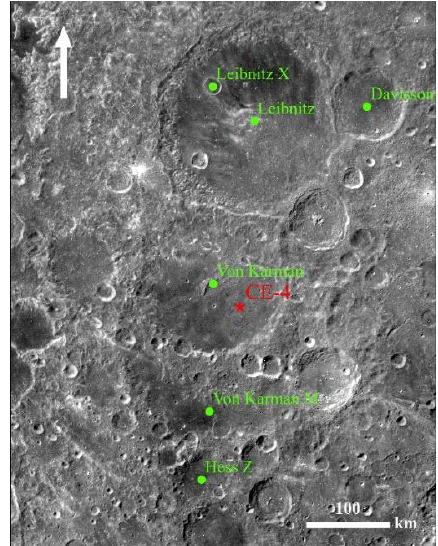
Figure 1. Geographical context of the CE4 landing area. The central location is (177.07° E, 43.19° S). The basemap is Chang’e -2 (CE-2) Digital Orthophoto Map (DOM) mosaic. The crater names are from the International Astronomical Union data base (https://planetarynames.wr.usgs.gov/, accessed on 19 December 2021). North is up.